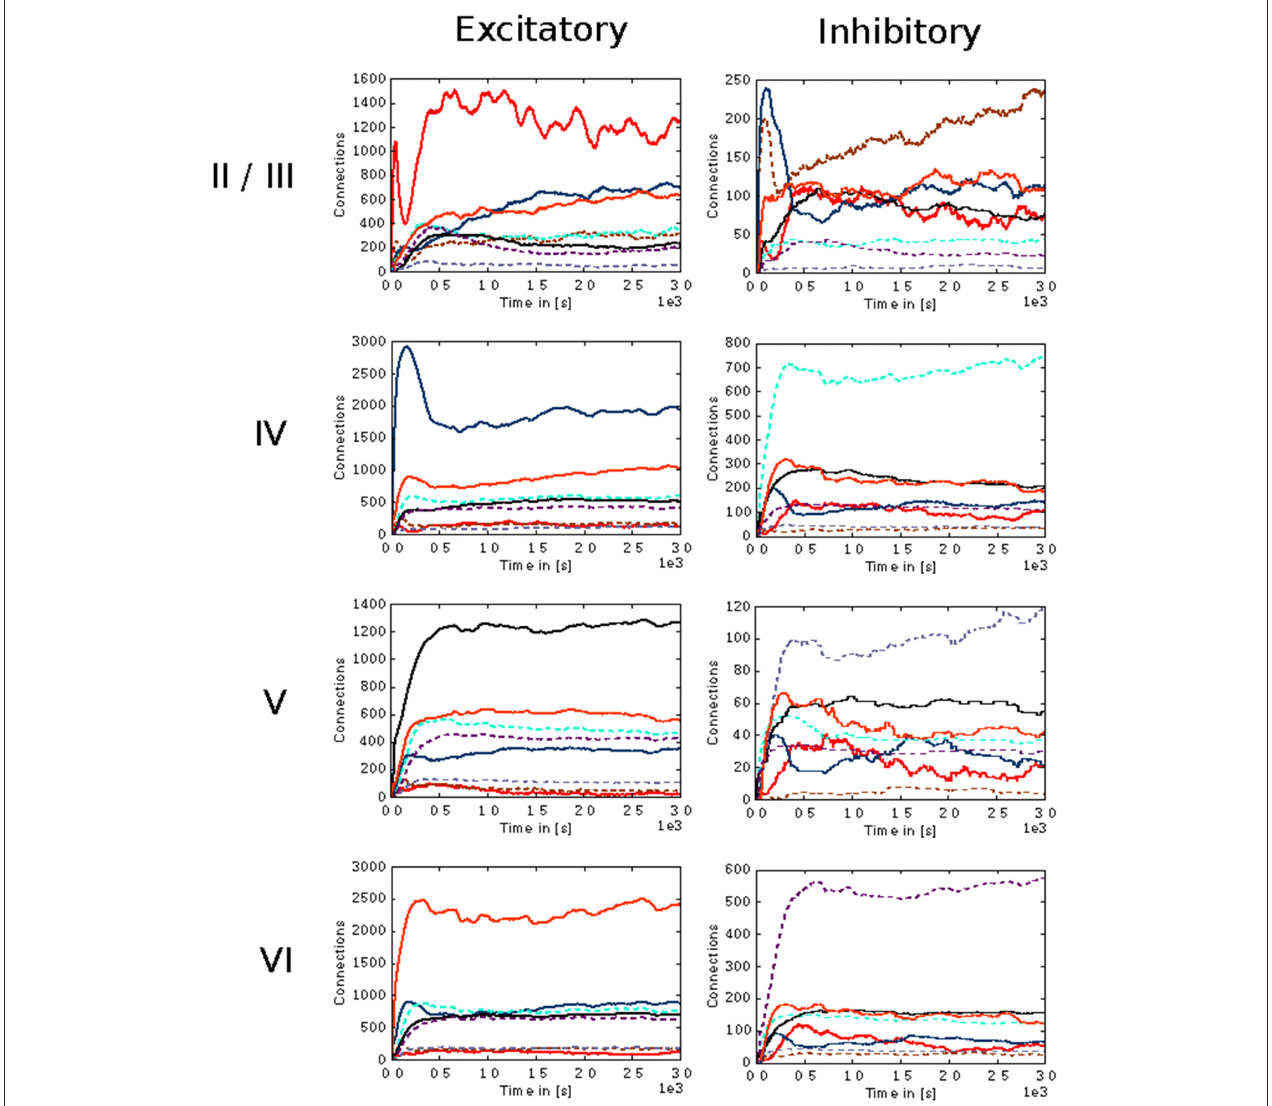
FIGURE 7 | Evolution of connectivity in the microcircuit model resolved by source and target population. Panels on the left and right illustrate efferent connections from excitatory and inhibitory populations, respectively, while the vertical arrangement indicates the layer of the source neurons. In each panel, the numbers of connections to each of the eight population in the model are shown as a function of time. The color of the curves indicates the target population, as in Figure 6 : connections to excitatory populations in layers II/III (red), IV (blue), V (black), and VI (orange) are shown as solid curves, and connections to inhibitory populations in layers II/III (brown), IV (cyan), V (gray), and VI (purple) are shown as dashed